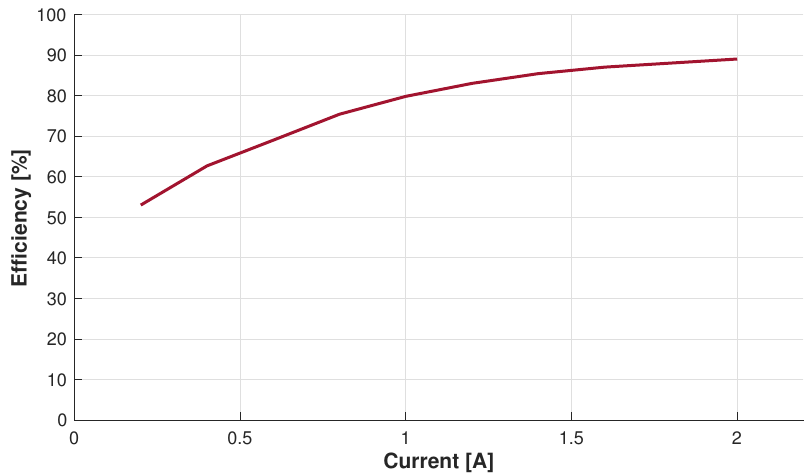
Figure 28. Experimental efficiency of the designed converter through different current